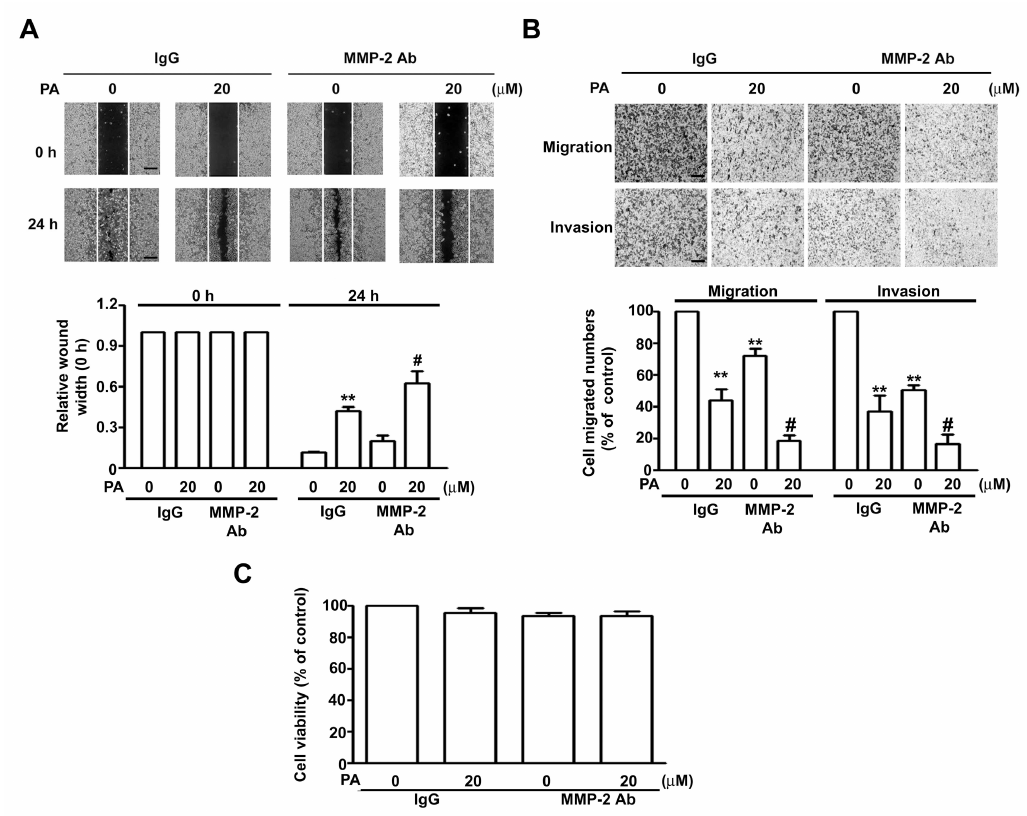
Figure 4. Effect of MMP-2 protein on PA inhibits cell migration and invasion in human HeLa cells. ( A ) HeLa cells were treated with/without 1 µ g/mL of IgG or anti-MMP-2 neutralizing antibody (MMP-2 Ab) in the presence or absence of PA (20 µ M) for 24 h, then followed by measuring the capacity of cell migration and invasion; ( B ) the wound-healing assay was expressed as relative wound width;